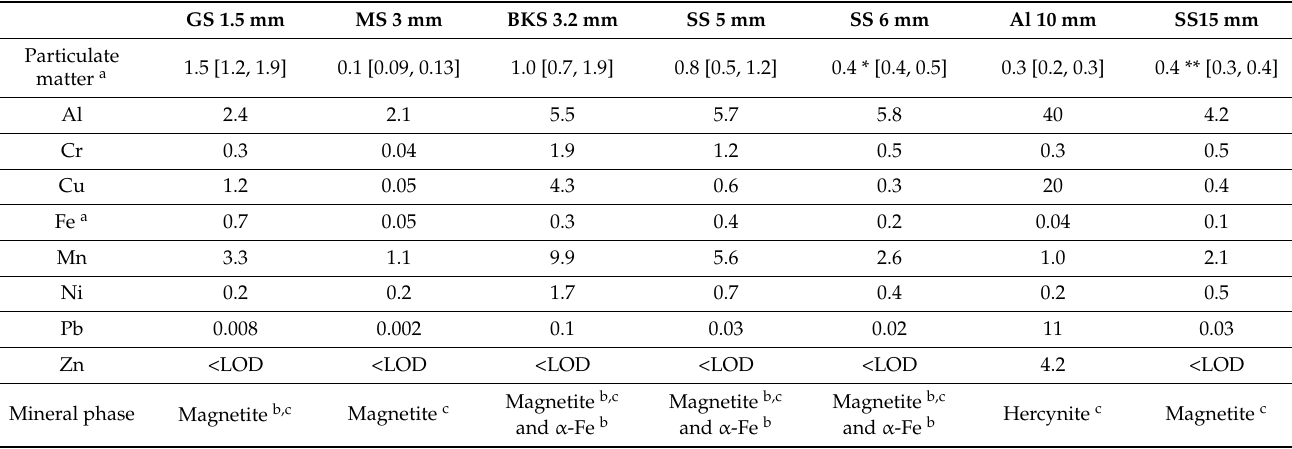
Table 3. Geometric mean concentration (mg/m 3 ) of particulate matter from seven parallel samples with minimum and maximum in brackets. Concentrations ( µ g/m 3 ) of elements in one of these samples of particulate matter freshly emitted during the cutting of various sheets: aluminium (Al), black steel (BKS), galvanized steel (GS), stainless steel (SS), and mild steel (MS). The main mineral phase was determined by SEM-EBSD, and/or XRD, for three to four samples.